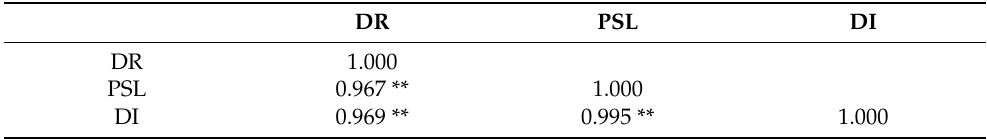
Table 2. Correlation of the three disease ratings assessed calculated according to the Pearson correla- tion